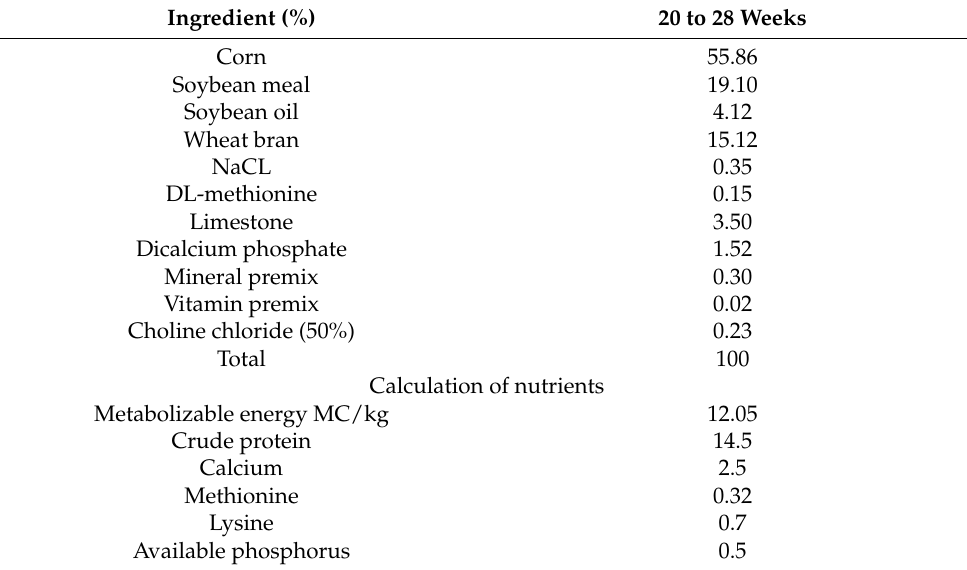
Table 1. Ingredient composition and calculation of ingredients in the basal diet for